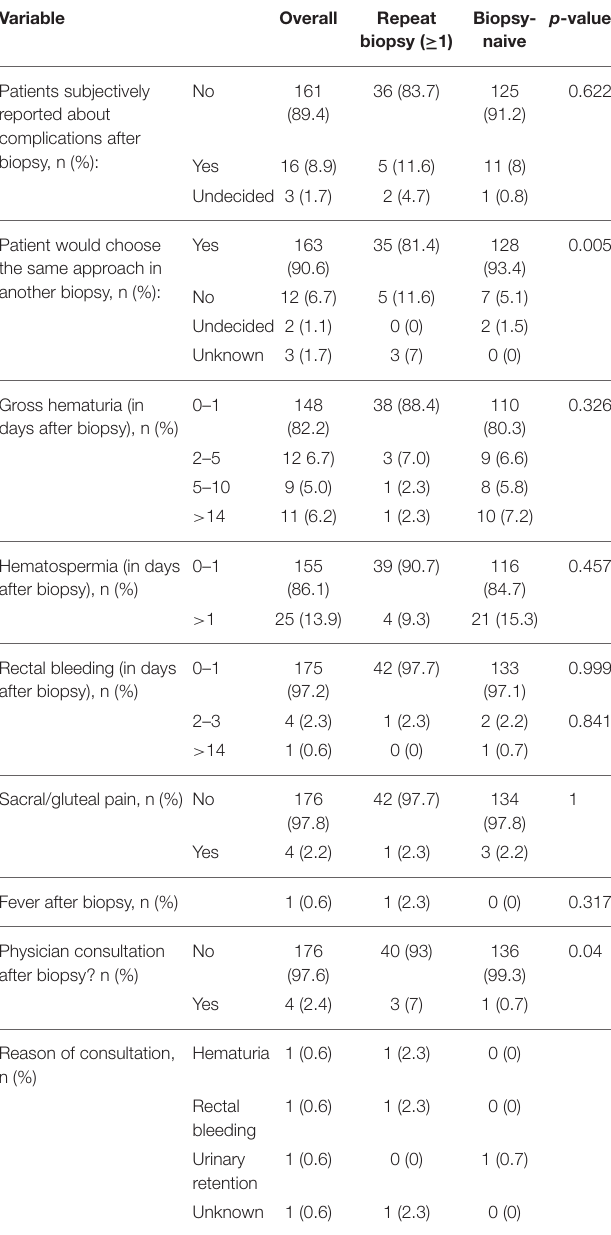
TABLE 3 | Complications after transrectal prostate biopsy of patients between 01/2018 and 05/2019 stratified for repeat biopsies and biopsy-naïve patients.